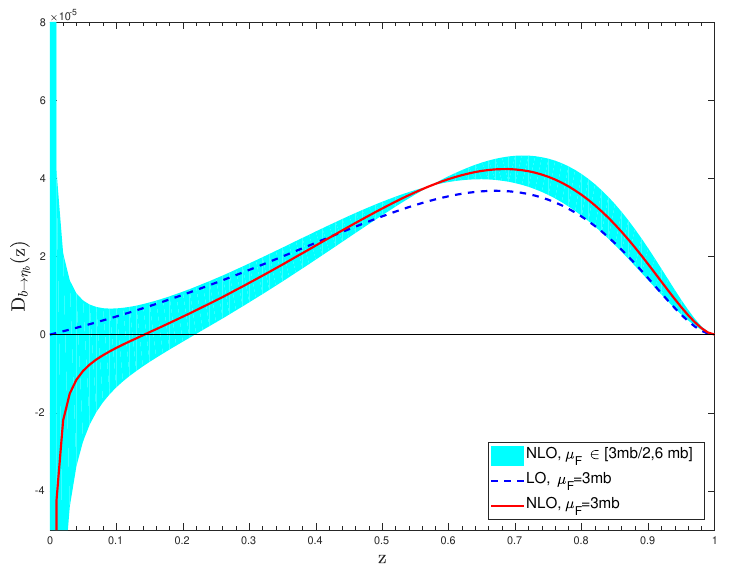
Figure 7 . The fragmentation function D c → η where µ F = 3 m b and µ R = 2 m b . The bands are obtained by varying the factorization scale µ F by a factor of